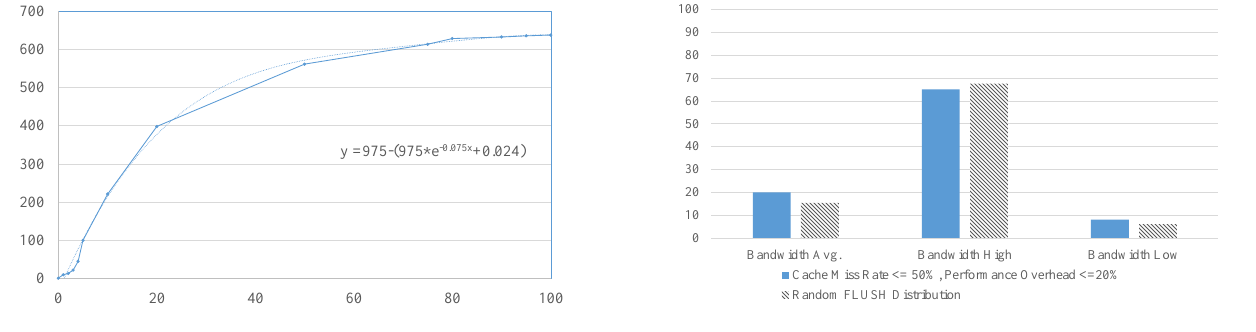
Figure 5. A function for side-channel bandwidth prediction based on statistical model.